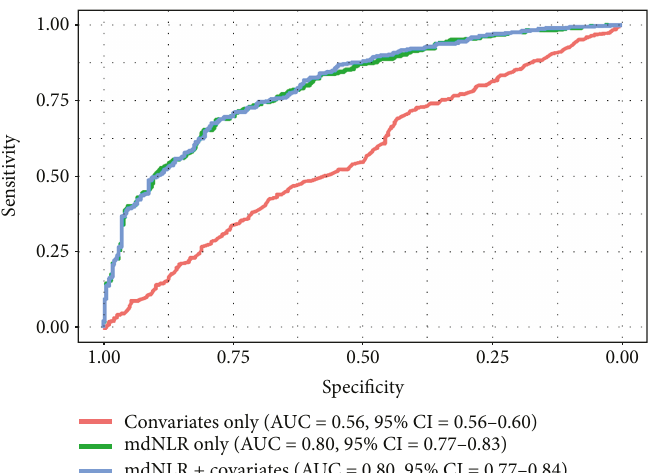
Figure 3: Diagnostic ability of mdNLR to distinguish new onset RA cases and controls. Each ROC curve was generated from a di ff erent classi fi er: shown below the fi gure with the area under the ROC curve (AUC) values. Covariates included age, gender, and smoking